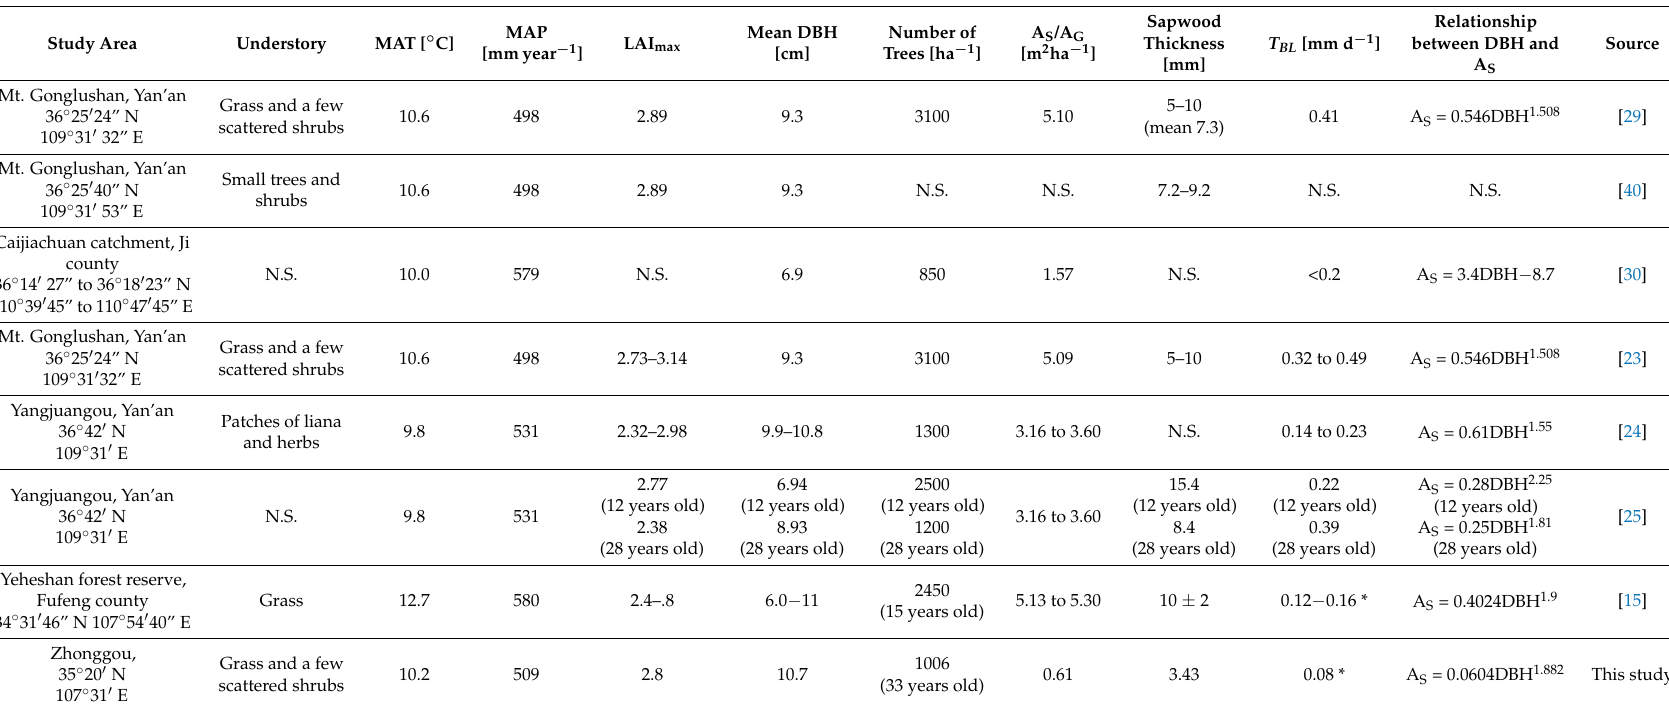
Table 1. Sap flow studies carried out in black locust stands across the Loess Plateau region. All the studies used Granier’s original calibration for the calculation of the sap flow densities, i.e., Equation (3). MAT = mean annual temperature, MAP = mean annual precipitation, LAI = Leaf Area Index, DBH = diameter at breast height, A S = sapwood area, A G = stand ground surface, T BL = transpiration of the black locust stand, N.S. = not specified. Study Area Understory MAT [ ◦ C]